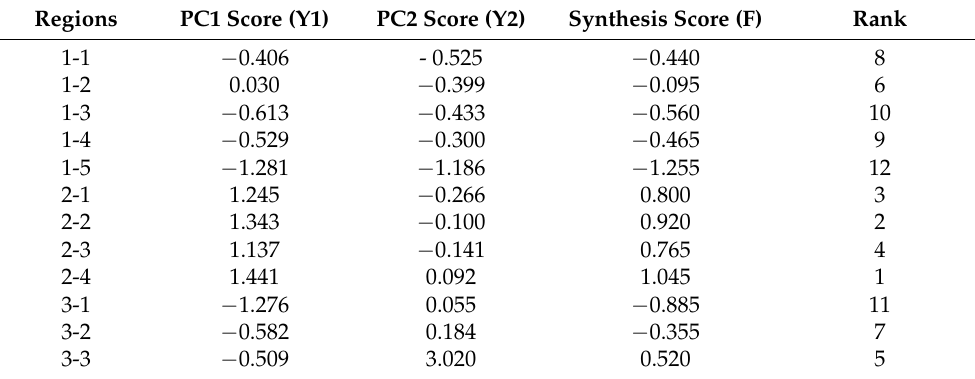
Table 9. Comprehensive score (F) and ranking of the fatty acid quality evaluation of fresh maize in three